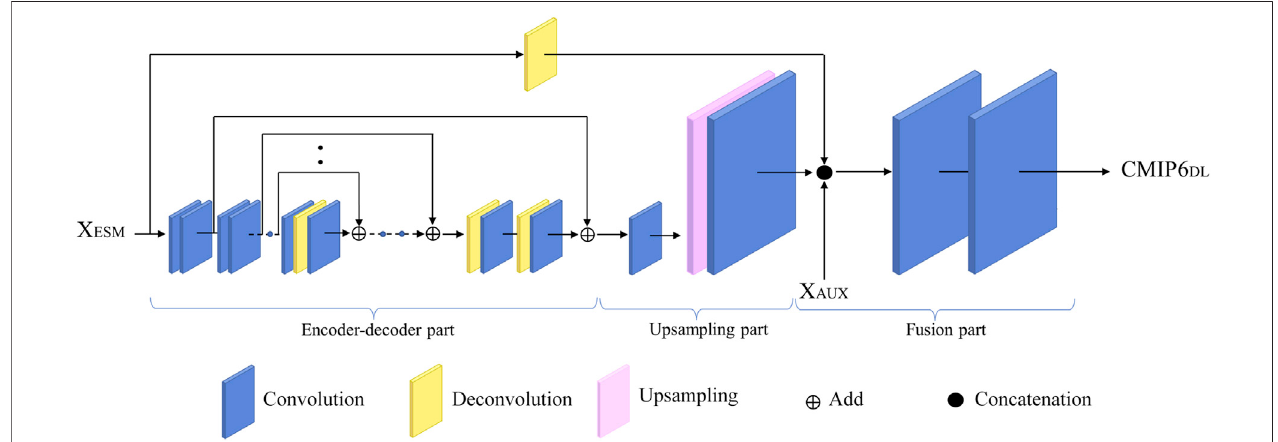
FIGURE 1 | Model architecture (Liu et al.,